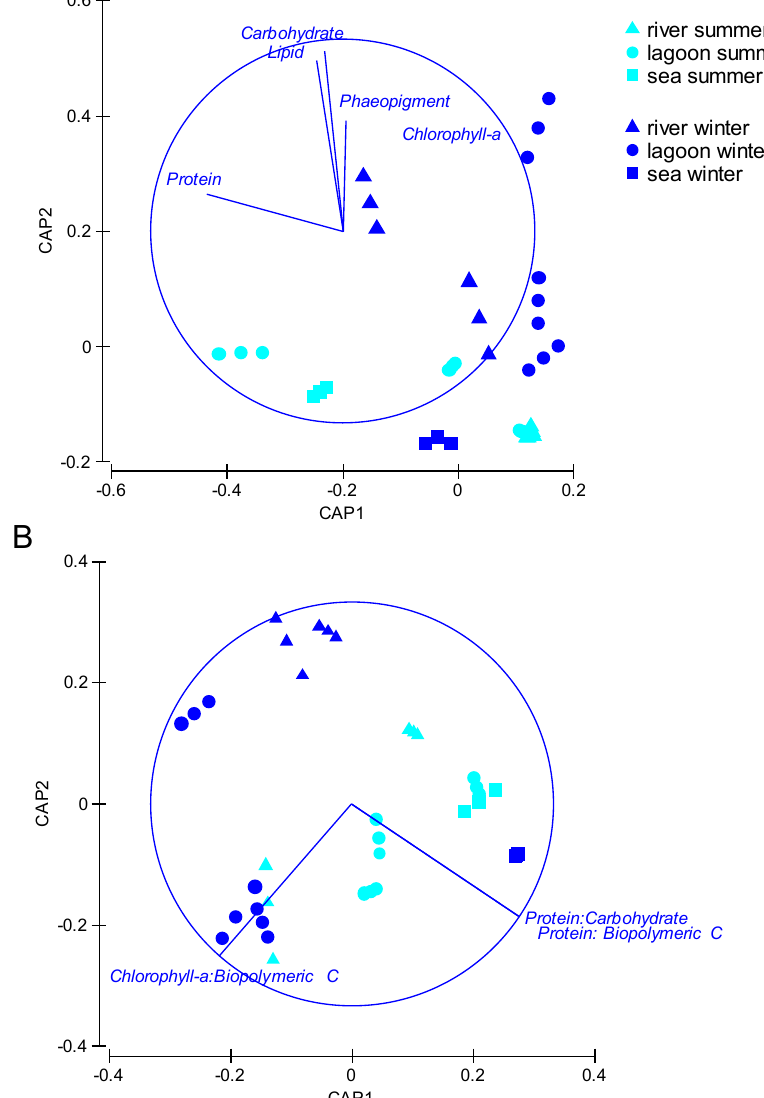
Figure 2. Output of the canonical analysis of principal coordinates (CAP) on the sedimentary organic matter biochemical composition ( A ) and nutritional quality ( B ).